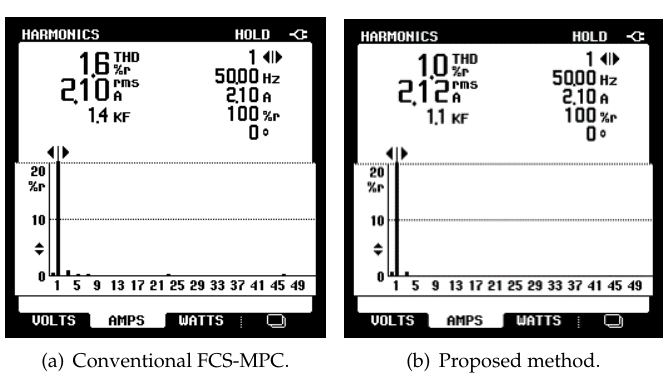
Figure 21. Experimental results of the conventional FCS-MPC.